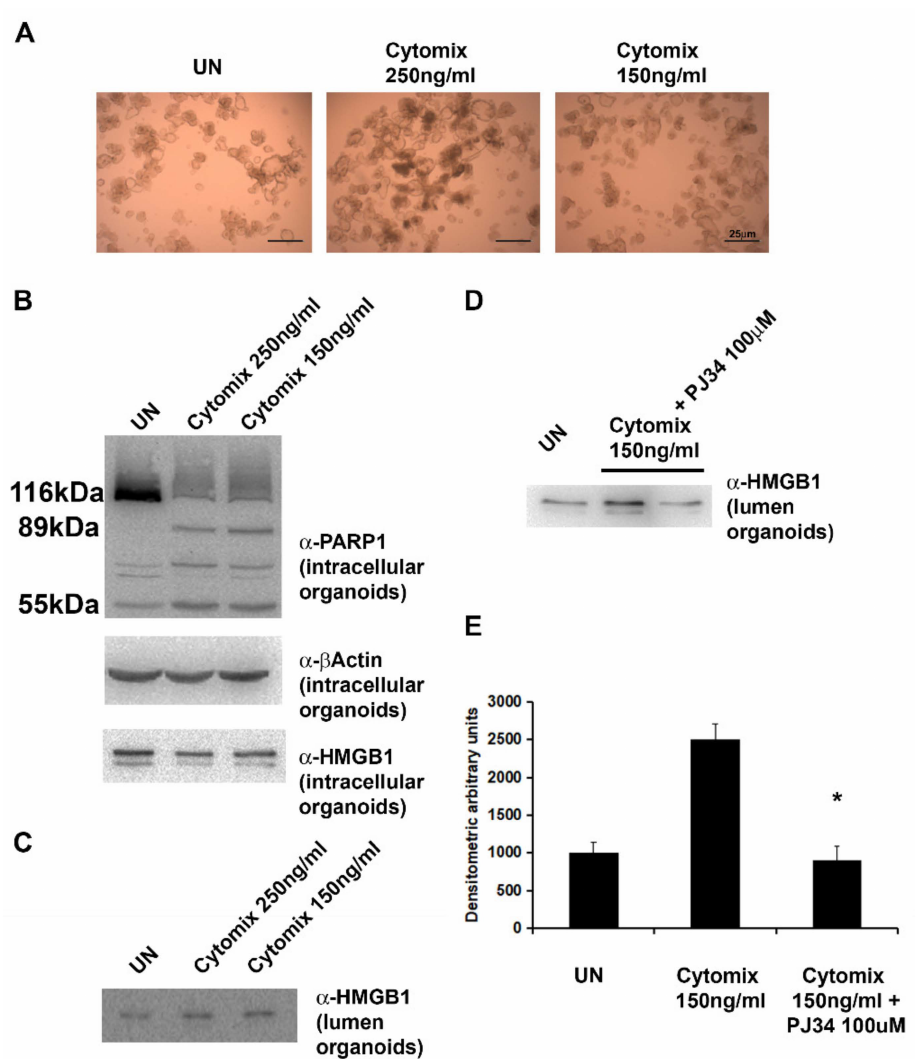
Figure 4. Pro-inflammatory cytokines INF γ and TNF α cause PARP1 activation and HMGB1 secretion in HIOs. The treatment with PJ34 significantly reduces the release of HMGB1 in the lumen of HIOs. HIOs were treated with cytomix or cotreated with cytomix and PJ34. ( A ) HIO morphology (Scale bar = 25 µ m). Western blot of ( B ) PARP1 and intracellular HMGB1 or ( C , D ) secreted HMGB1. ( E ) Densitometric analysis of secreted HMGB1. The experiment was performed in triplicate. Statistical analysis was performed using the Mann–Whitney U test. * p <